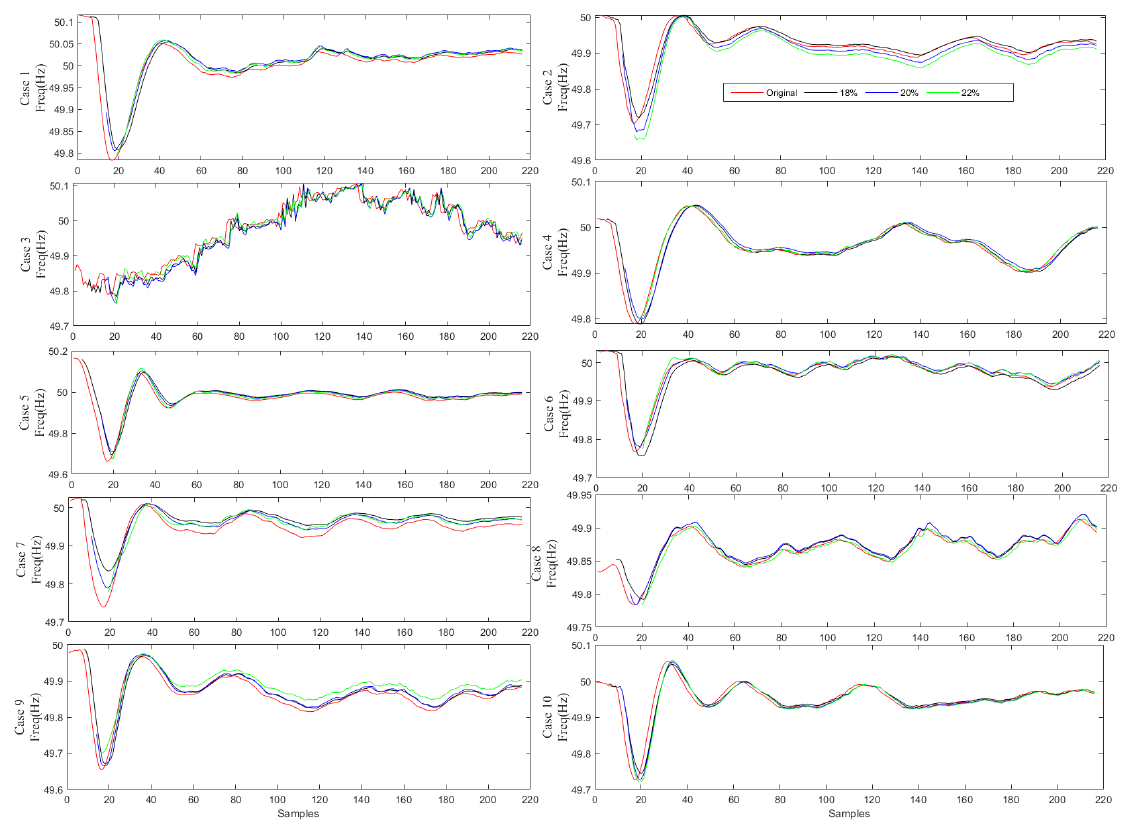
Figure 14. Results for the NAR models in the Sweden measurement